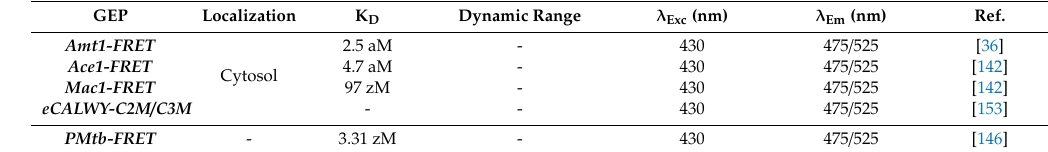
Table 4. Selection of FRET-based GEPs suitable for subcellular Cu +